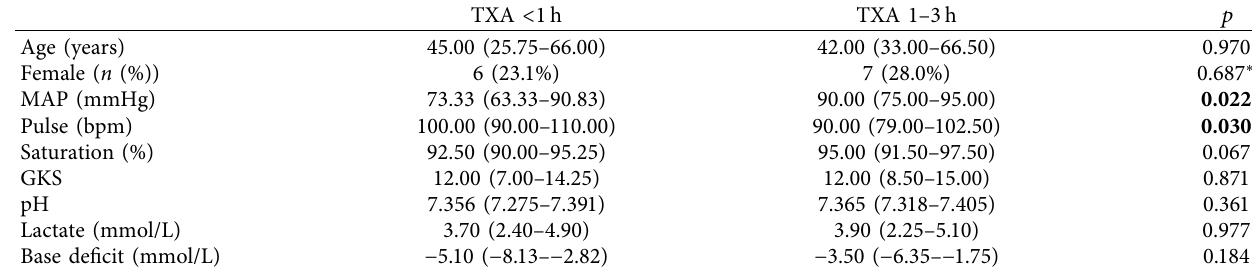
Table 4: The factors affecting the time of TXA